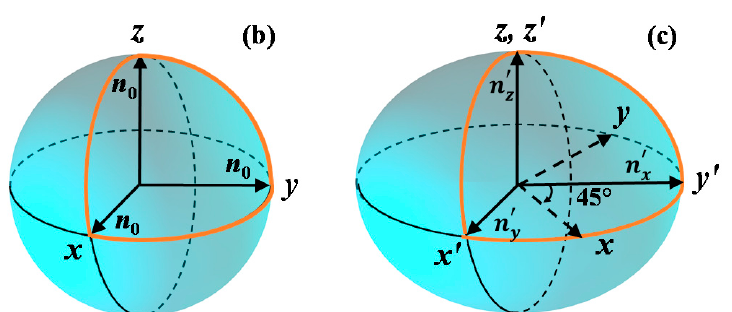
Figure 2. The DFG configuration in crystals of the 43m point group: ( a ) electric field, optical beam propagation, and polarization directions; ( b , c ) the refractive index ellipsoids before and after applying the electric field along the z axis. The Au planar electrodes are coated to generate a uniform electric field along the [001] direction.